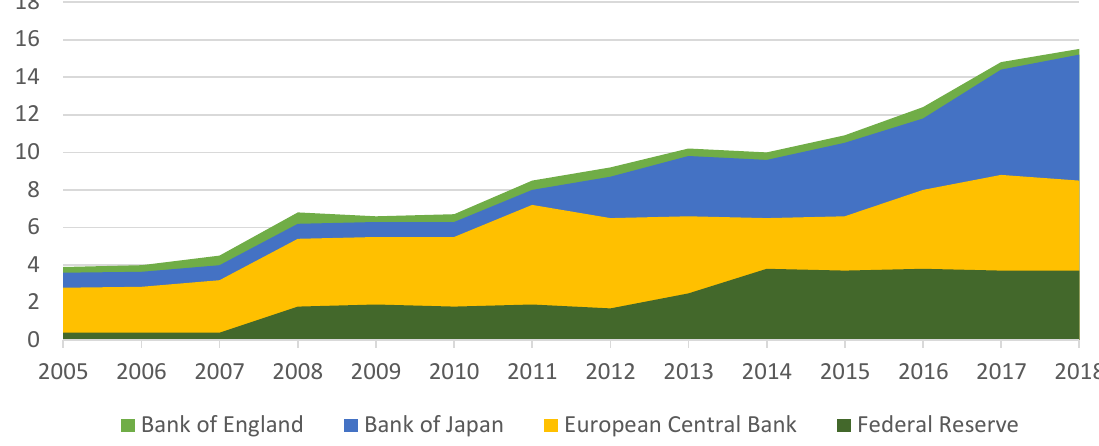
Figure 2. Dynamic of assets of central banks, USD trillion